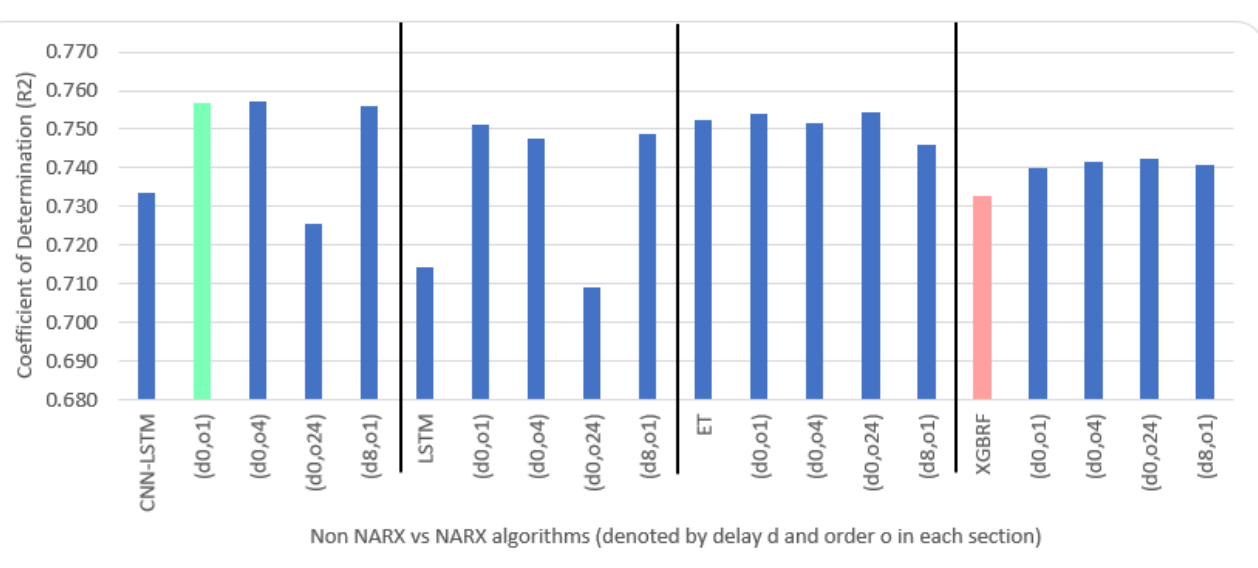
Figure 28. Evaluation results of non-NARX and NARX in terms of index of agreement for Manches- ter dataset.